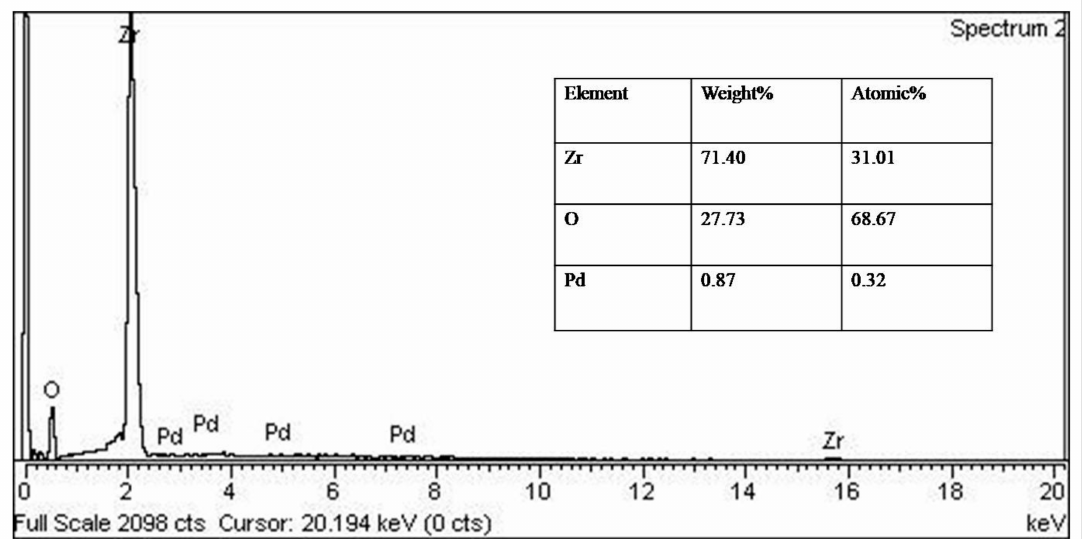
Figure 4. EDX spectrum of Pd/ZrO 2